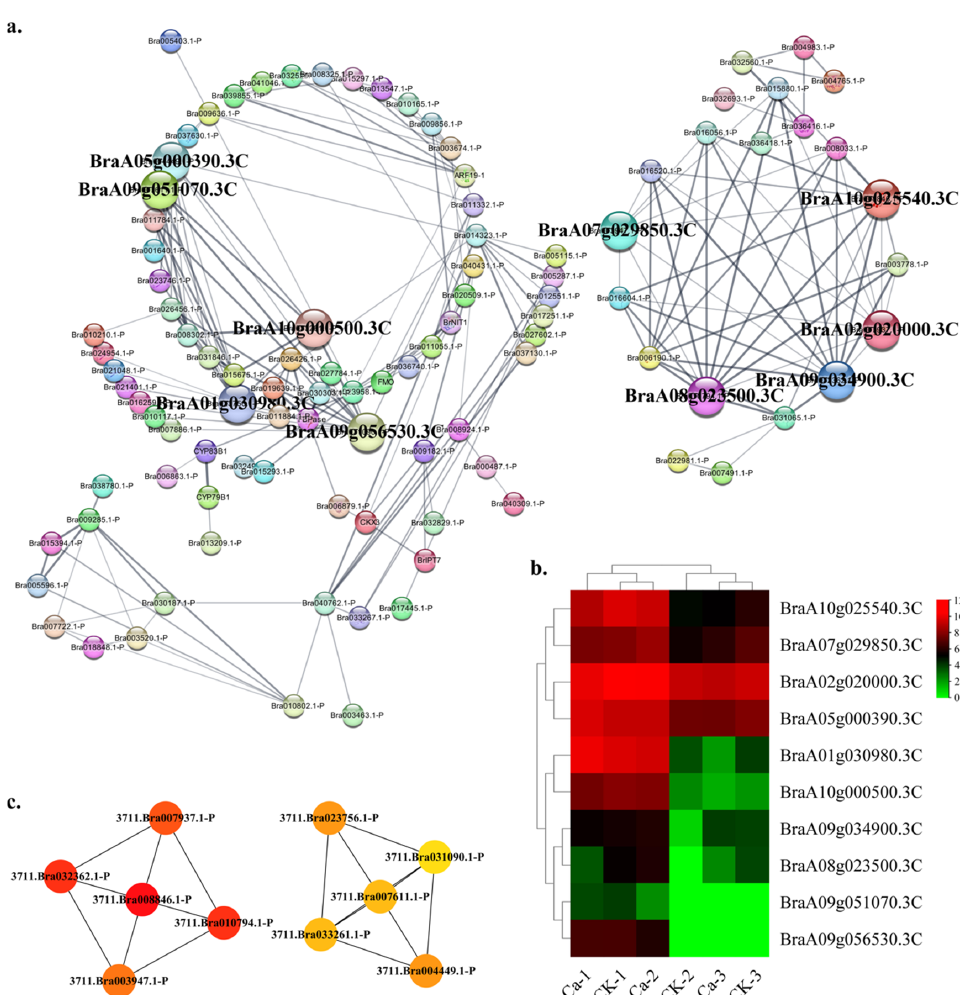
Figure 11. Protein–protein interaction (PPI) analysis in hormone-related DEGs category. ( a ) PPI network in the hormone category. ( b ) Heatmap of the hub gene expression pattern. ( c ) Hub genes’ interactive relationship of the gene regulatory network.